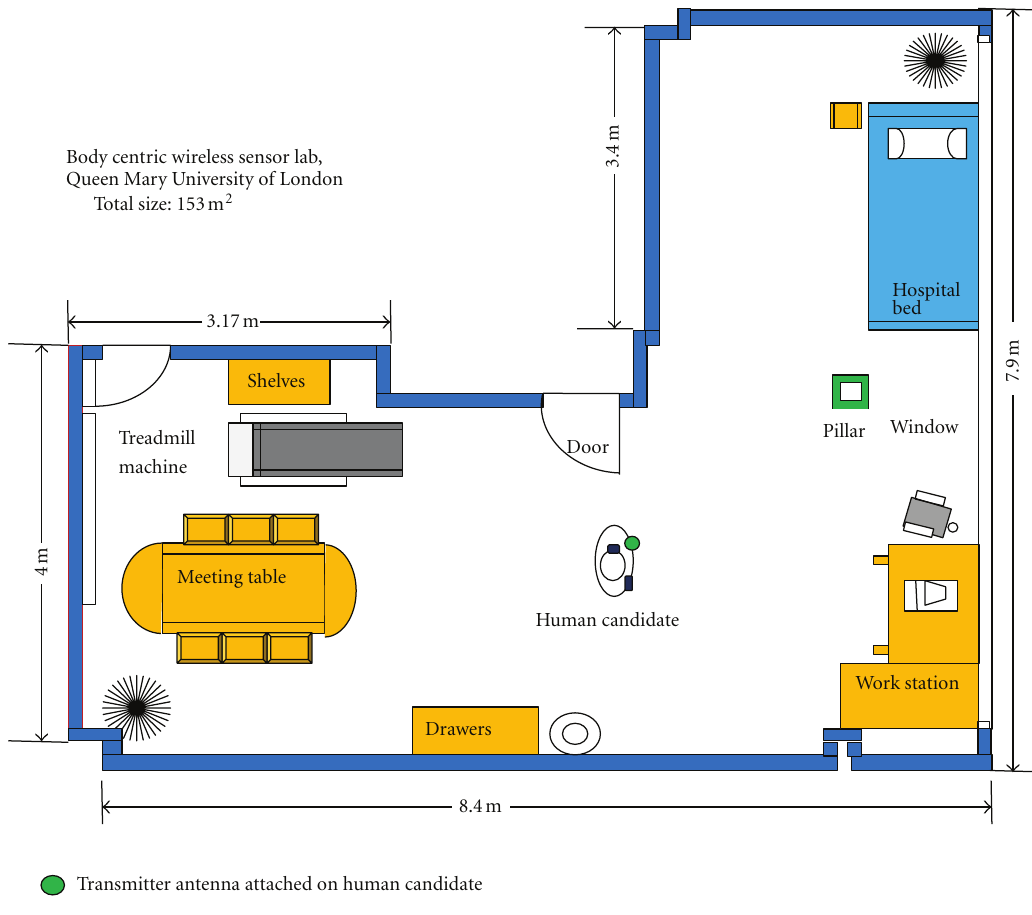
Figure 4: Dimensions and geometry of the Body-Centric Wireless Sensor Lab (housed within the Department of Electronic engineering, Queen Mary University of London, London, UK) where the indoor on-body radio propagation measurements for the presented work are